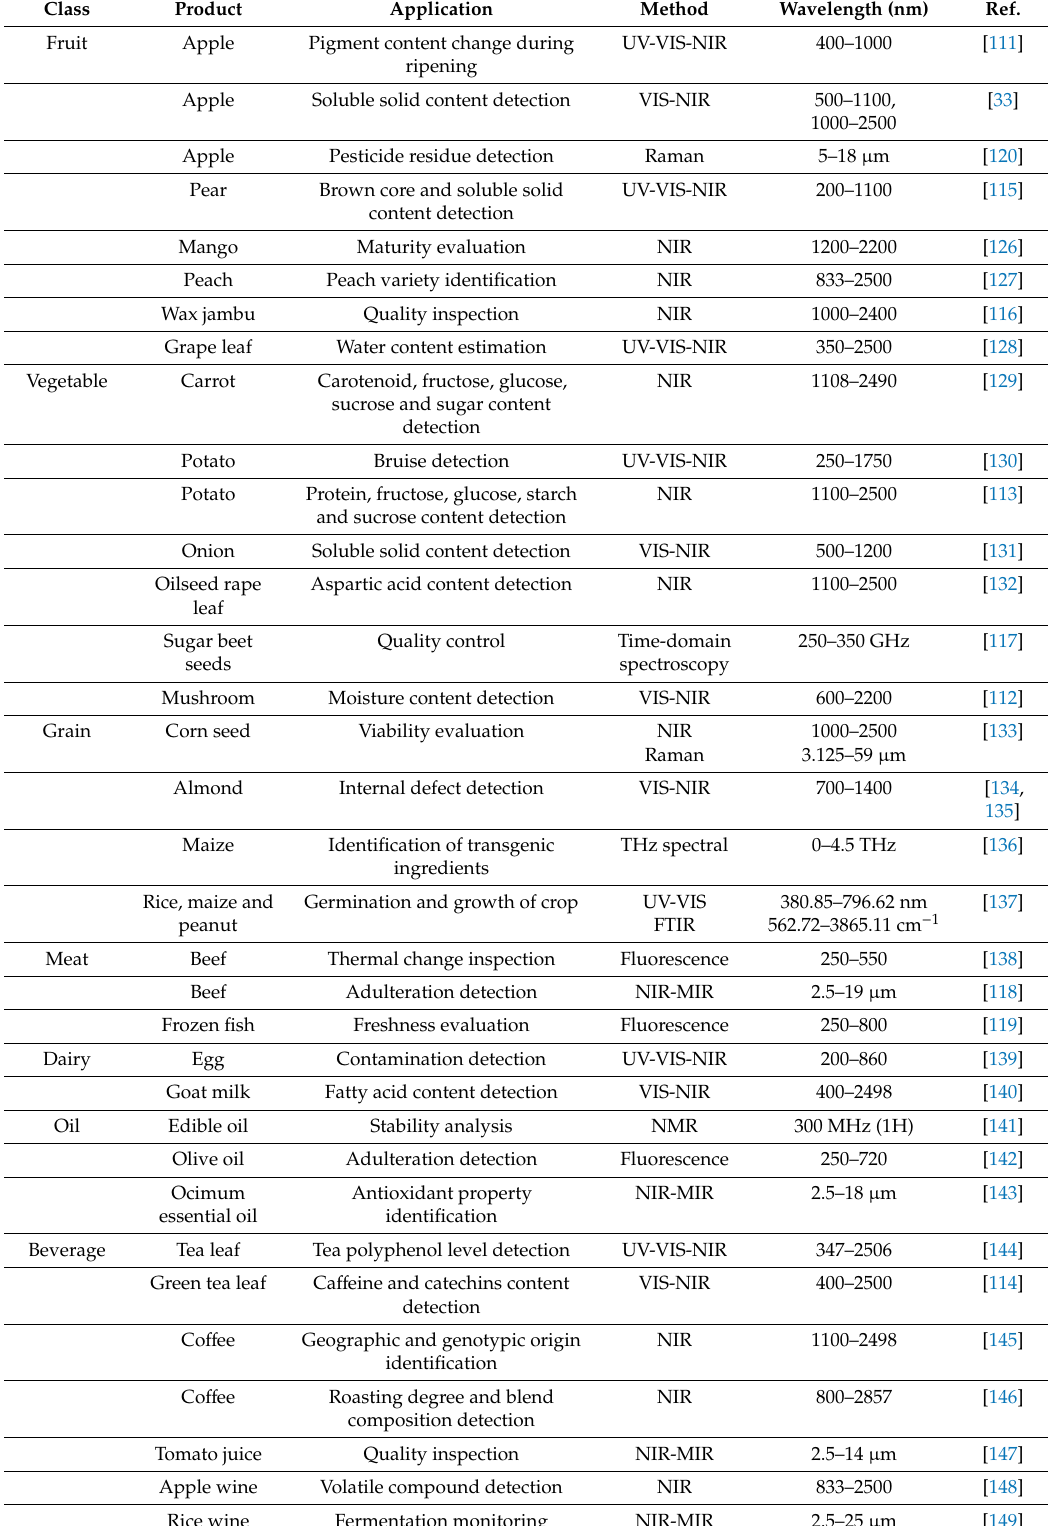
Table 6. Applications of spectroscopy technique in